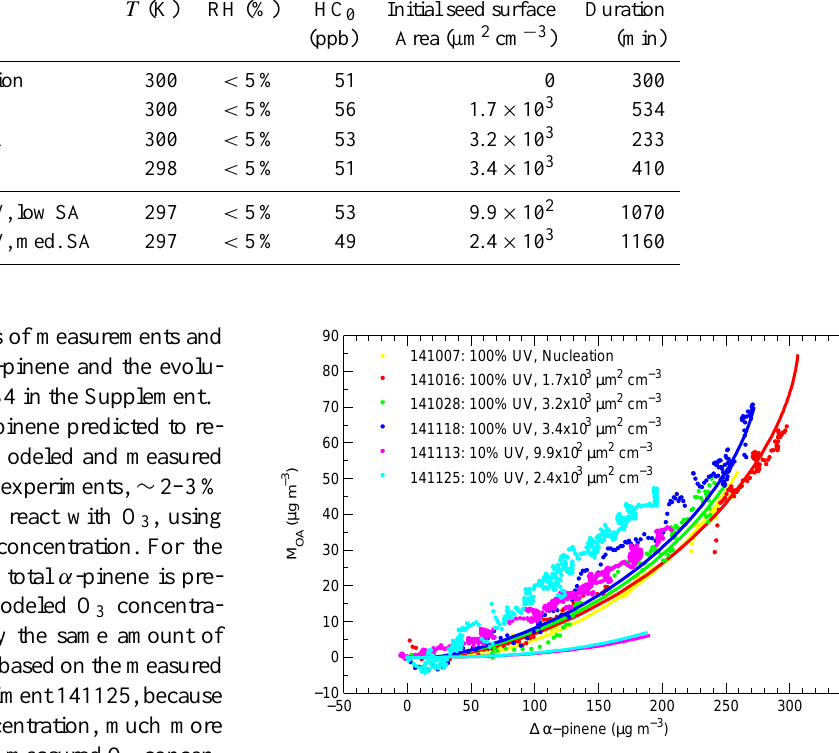
Figure 2. Mass of SOA, M OA , as a function of reacted α -pinene. Experimental data are shown with filled circles, with colors corre- sponding to individual experiments (see Table 1), and have been corrected for particle wall loss (see text). Predictions using the de- fault GECKO-A are shown as solid lines, with the colors corre- sponding to the different experiments. In GECKO-A, the vapor– particle accommodation coefficient is set to α p = 1, and the vapor wall loss rate is set to k gw = 10 − 3 s − 1